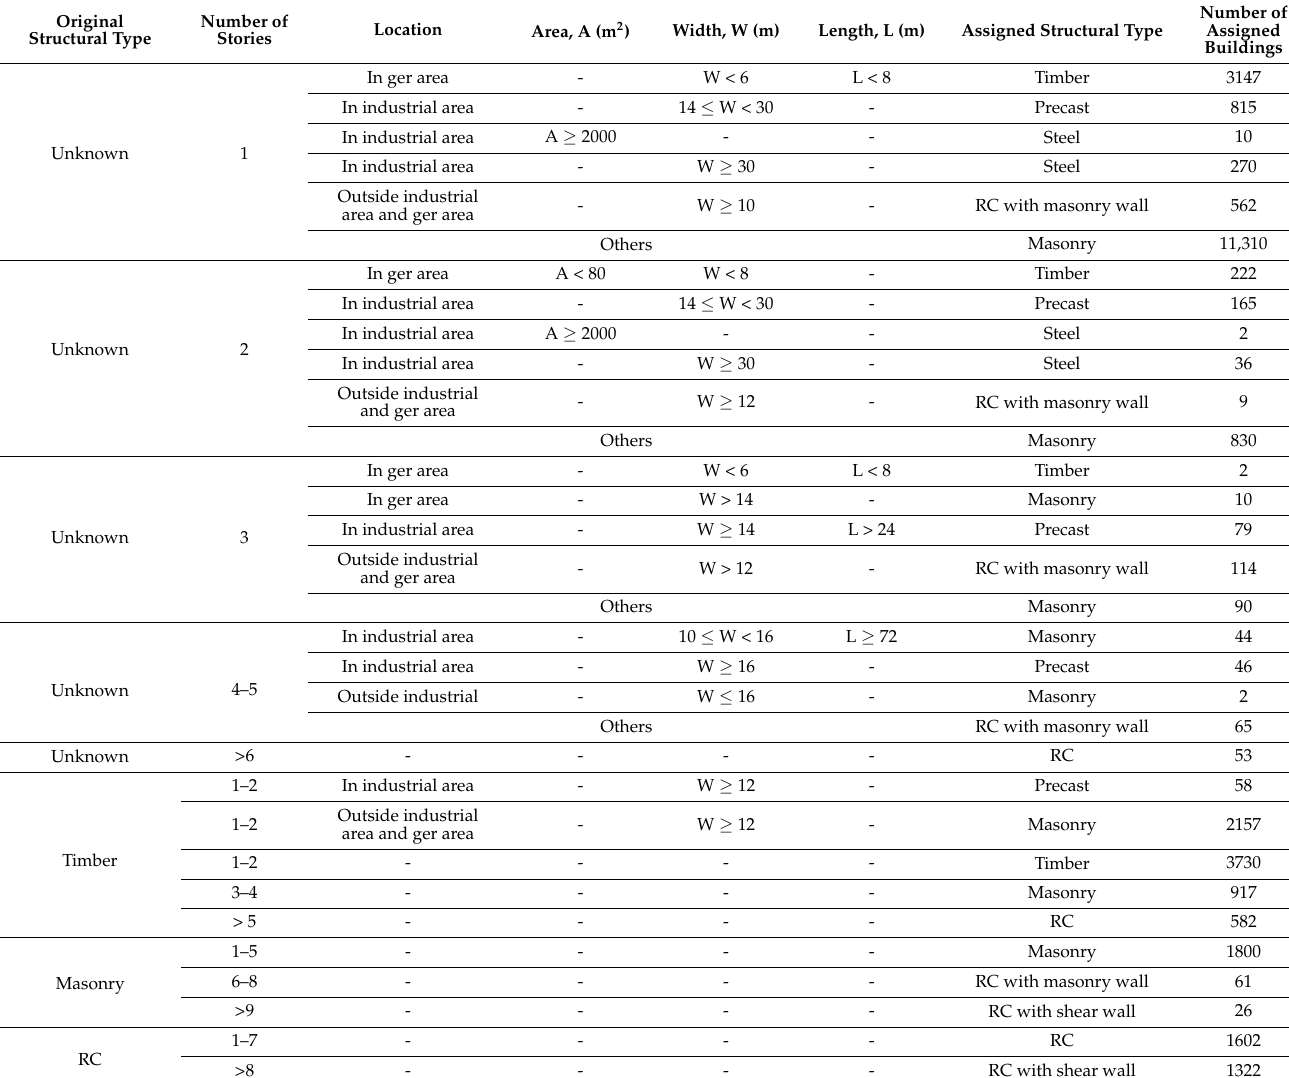
Table 5. Criteria for defining the structural type of